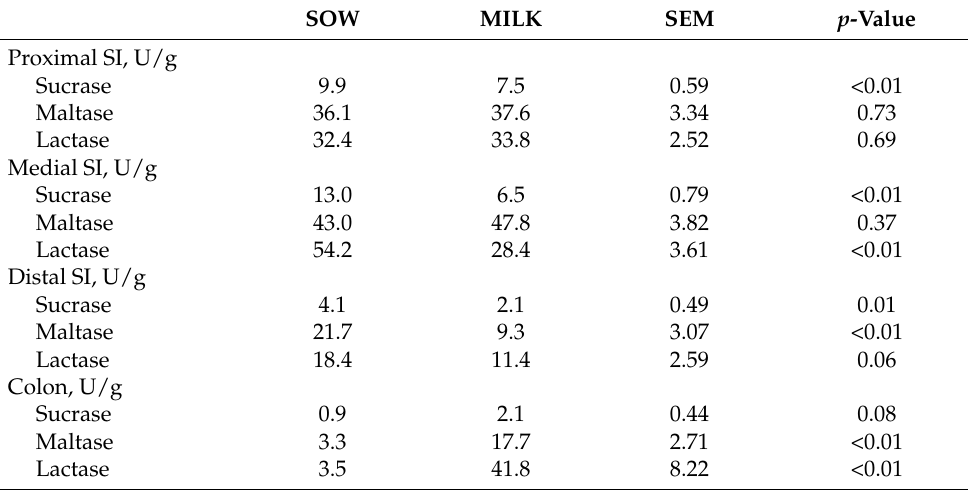
Table 5. Activity of sucrase, maltase, and lactase in the proximal, medial, and distal parts of the small intestine and in the colon of sow (SOW) and artificially (MILK) reared piglets. SOW MILK